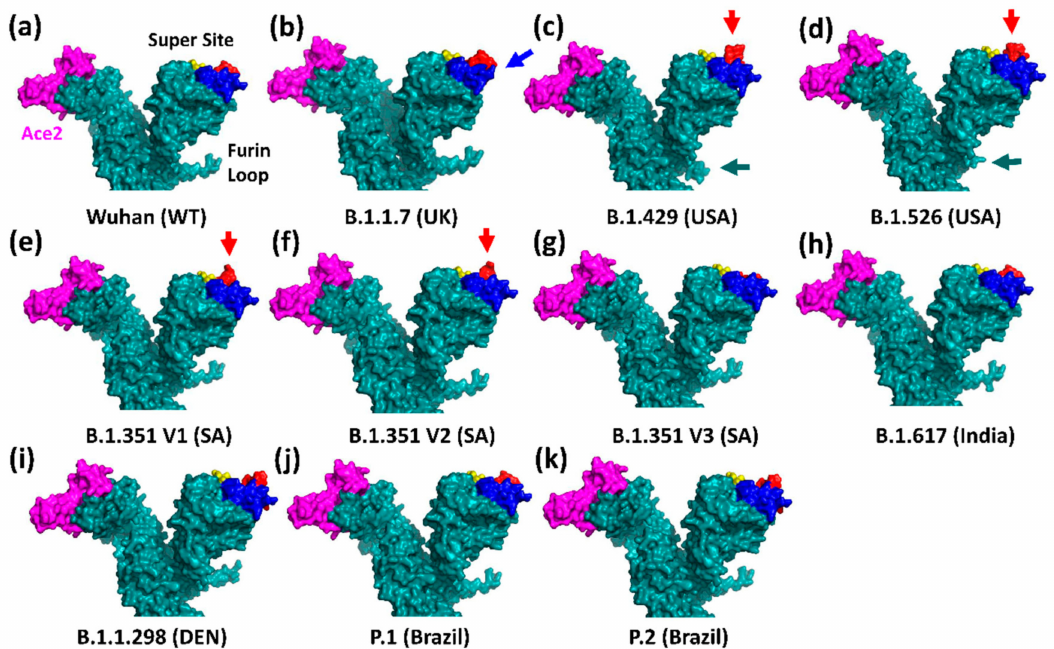
Figure 6. Models of the protein surfaces of wild-type Spike and its variants with the three loops of the super site, the hAce2 binding site, and the furin loop indicated. ( a ) The Wuhan wild-type spike (loops N1 (14–20aa): yellow; N3 (140–158aa): blue; N5 (245–264aa): red; hAce2 binding site (magenta); furin loop (green arrow)); ( b ) B.1.1.7 (UK); ( c ) B.1.429 (USA); ( d ) B.1.526 (USA); ( e – g ) sub-variants V1, V2, and V3 of B.1.351 (South Africa); ( h ) B.1.617 (India) (please note the model contains only the mutations listed in Table 1); ( i ) B.1.1.298 (Denmark); ( j ) P.1 (Brazil); ( k ) P.2 (Brazil). Since three-D structure are not yet published for all mutated Spike proteins, models were generated with the mutated amino acid sequences of Spike using the Phyre2 (Protein Homology/analogy Recognition Engine V 2.0) server. The resulting structure files were then rendered with PyMOL (Molecular Graphics System, Version 2.0 Schrödinger, LLC). Arrows indicate the predicted structural changes in loop N3 (blue) or loop N5 (red). Please note that the furin loop is modelled differently in both USA variants compared to all other variants. The reason for this is as yet